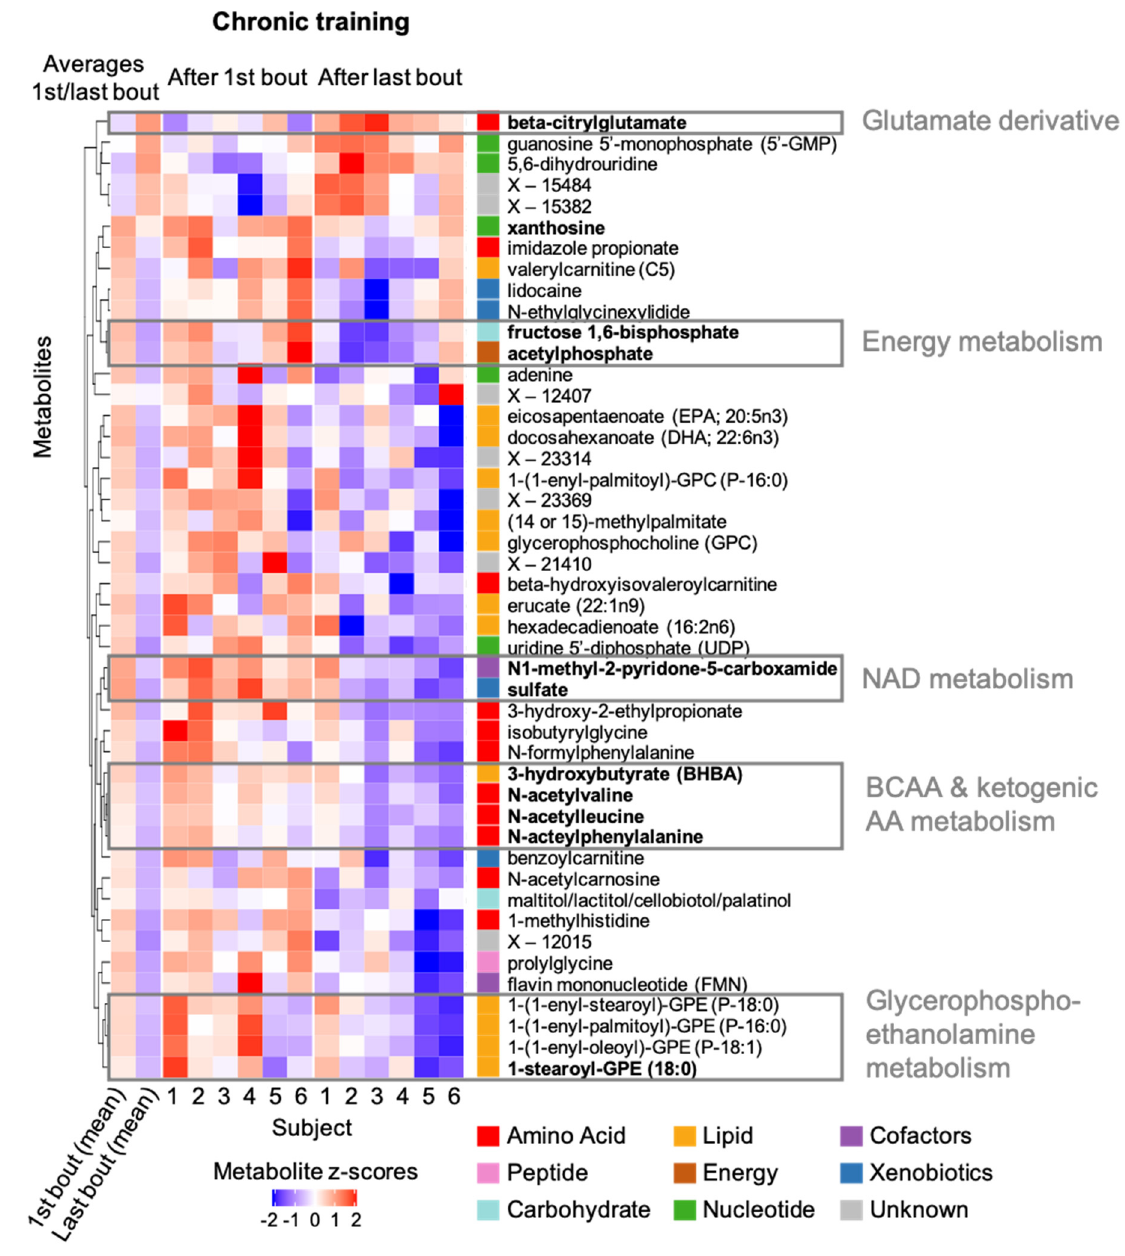
Figure 5. Heatmap of metabolites changing in response to chronic training. Individual and average metabolite levels after the first bout of exercise and after the last bout of exercise following five ‐ week resistance training are shown as z ‐ scores for all 46 metabolites with changes ( p < 0.05) in response to chronic training; red color indicates higher levels compared to all levels measured for the specific metabolite in the present study; analogously, blue color indicates lower levels; names of metabolites with significant changes after correcting for multiple testing are shown in bold. Metabolites were clustered by their similarity in metabolite levels at the two conditions across the participants; the resulting clusters are displayed in the dendrogram on the left of the heatmap. Selected clusters and their link to exercise ‐ related molecular processes are highlighted. BCAA: branched chain amino acid; AA: amino acid; NAD: nicotinamide adenine dinucleotide.